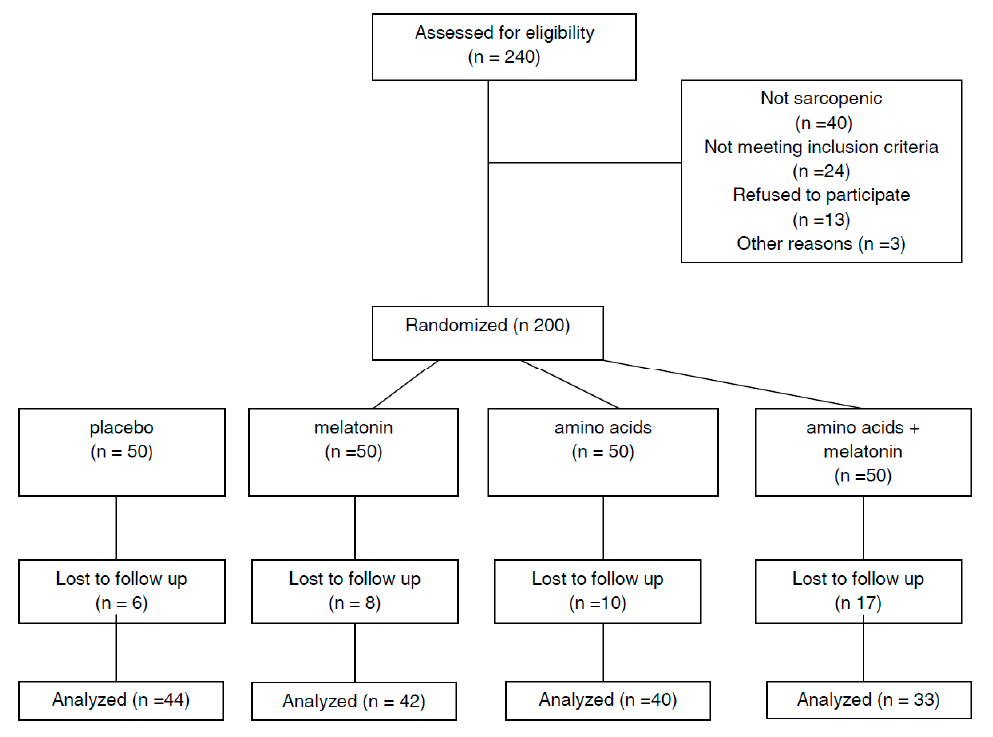
Figure 1. Flow diagram of the study.